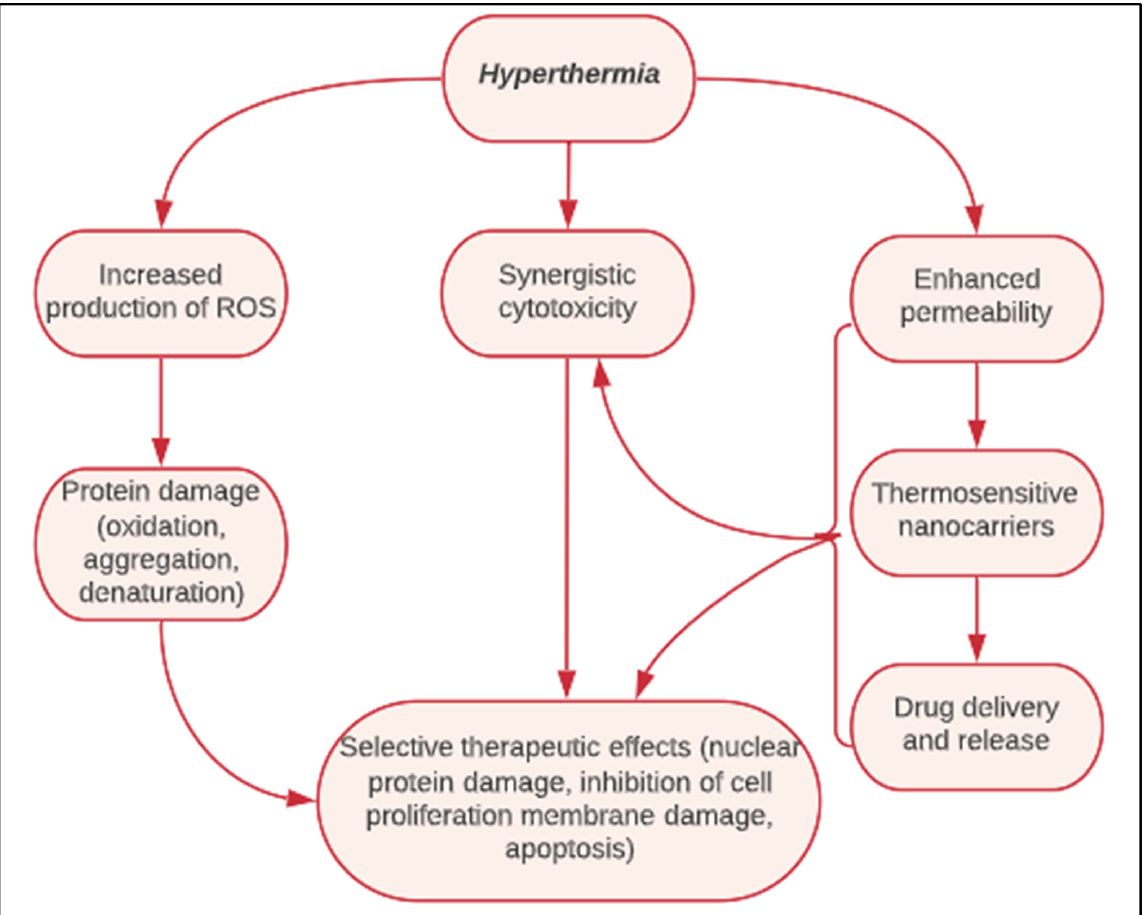
Figure 8. Schematic illustrating the multifactorial effects of temperature-triggered hyperthermia, from its stand-alone cytotoxicity to inducing synergistic cytotoxic effects when combined with drug delivery systems.